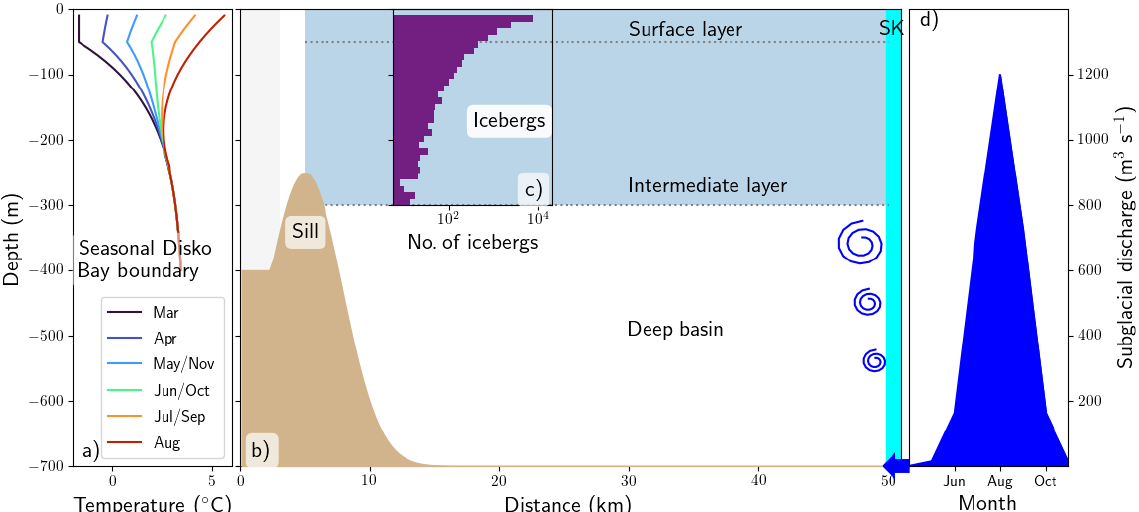
Figure 2. Model domain and forcings: (a) Disko Bay temperature boundary condition from March to August. (b) A 2D section of the model domain: blue shading indicates iceberg extent; dotted lines separate vertical layers used in describing the results; light grey shading indicates the OBCS sponge layer where the western boundary is restored to the boundary conditions; the vertical turquoise block to the east indicates the vertical front of Sermeq Kujalleq (“SK”). (c) Number of icebergs of each depth at 10m intervals. (d) Monthly subglacial discharge